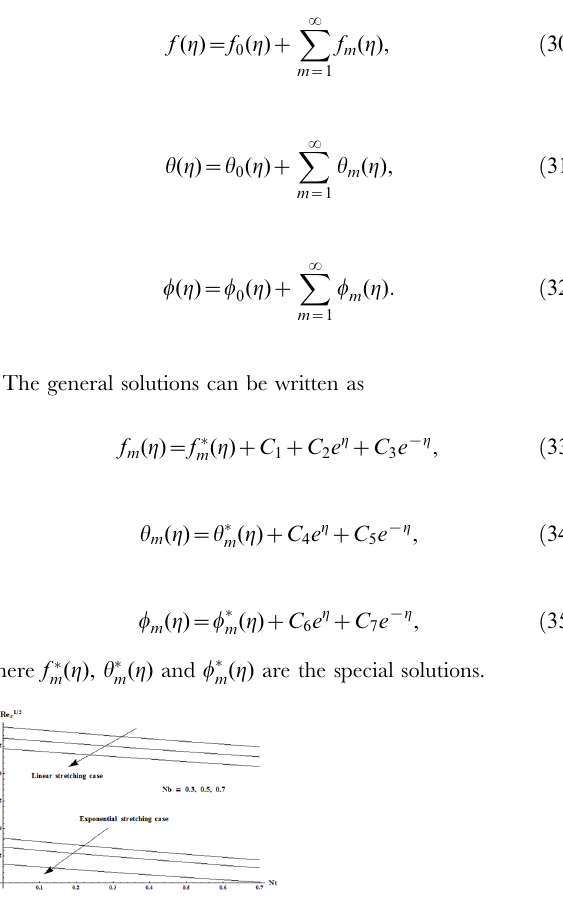
Figure 14. Variation in Nusselt and Sherwood numbers for different values of Nb vs Nt when l 1 ~ 0 : 3, b ~ 0 : 2, M ~ 0 : 5, Pr ~ 0 : 7, Le ~ 1 : 0, Rd ~ 0 : 3 ~ Ec , A ~ 0 : 1 and B ~ 0 : 2 :